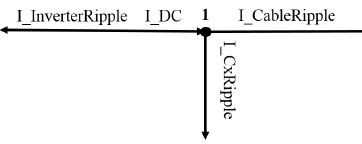
Figure 4. System relevant currents at the marked point (1) in Figure 3, that are the bases for the Kirchhoff’s analysis.